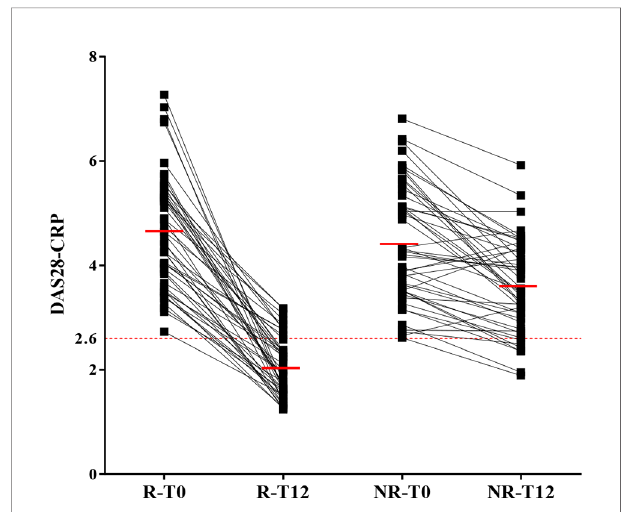
FIGURE 1 | Classi fi cation of ERA patients in good and non-responders according to DAS28-CRP. The 100 patients suffering from ERA were divided in two groups: good (R) and non-responders (NR) according to the variation of DAS28-CRP from T0 and T12 (after 12 months of treatment). When DAS28-CRP ≤ 2.6, the patient is in remission (dotted red line). The mean for each group is indicated with a full red line. Four patients were removed from the analysis because they did not ful fi ll the criteria for either R or